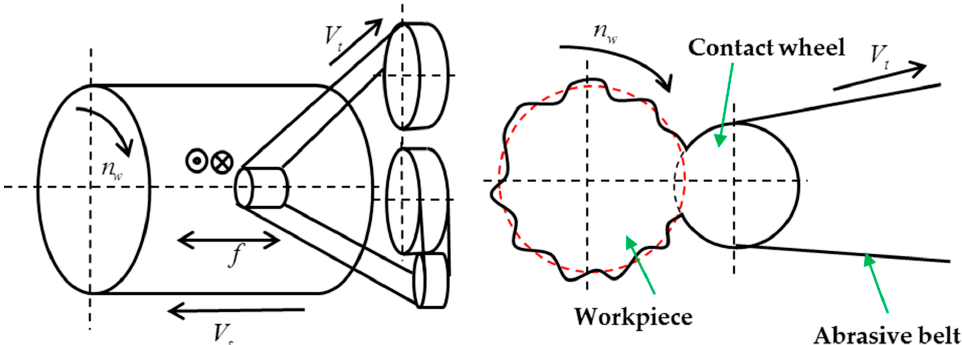
Figure 1. Schematic diagram for abrasive belt polishing.